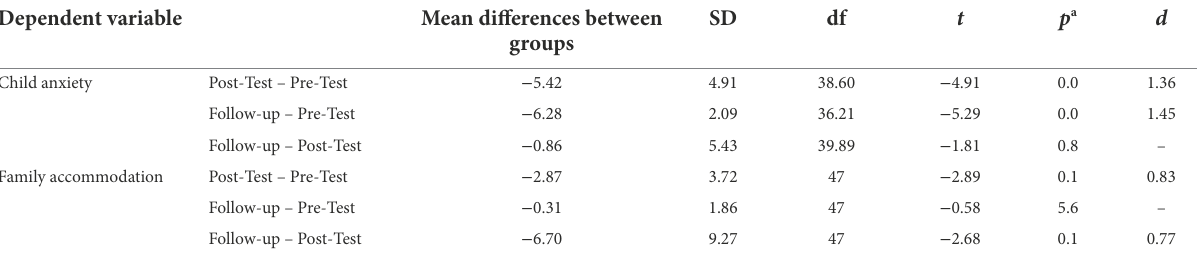
TABLE 9 Gain score analysis via independent samples t